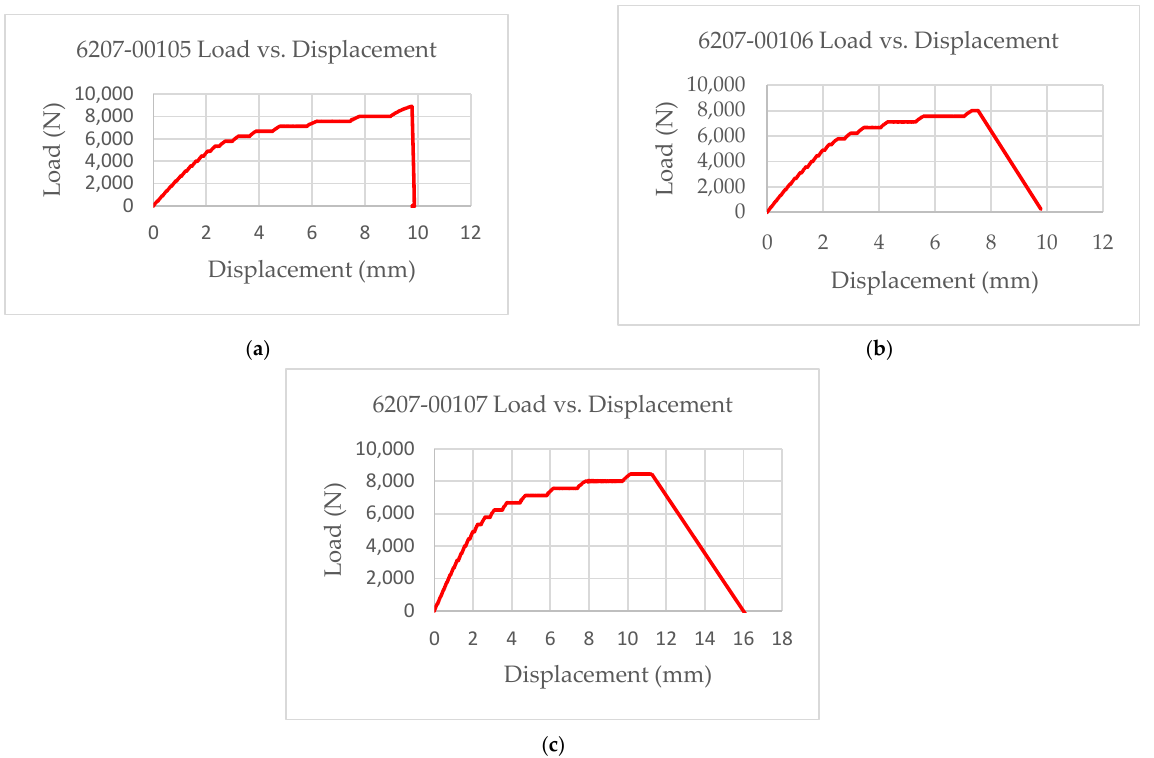
Figure 7. Load versus displacement characteristics of multifunctional test specimens: ( a ) 6207-00105; ( b ) 6207-00105; ( c ) 6207-00107.